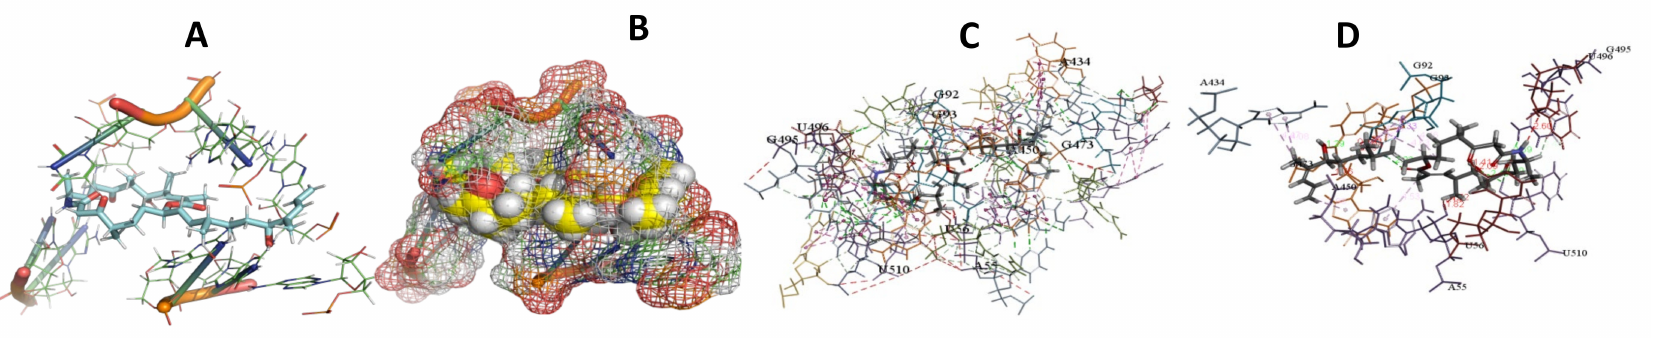
Figure 5. T. Cruzi bound to Angiolam. ( A ): Best binding pose and nucleotides involved. ( B ): Schematic binding pocket. ( C ): shows the Nucleotides component that re involved in binding. ( D ): Shows the main bonds involved between the compound and the nucleotide